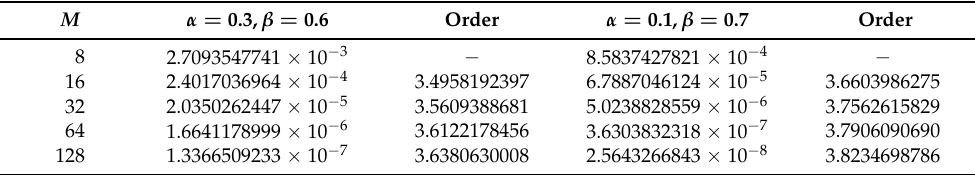
Table 3. Maximum errors and decay rate with N = [ M ( 4 − α ) / ( 4 − β ) ] . M α = 0.3, β = 0.6 Order α = 0.1, β =